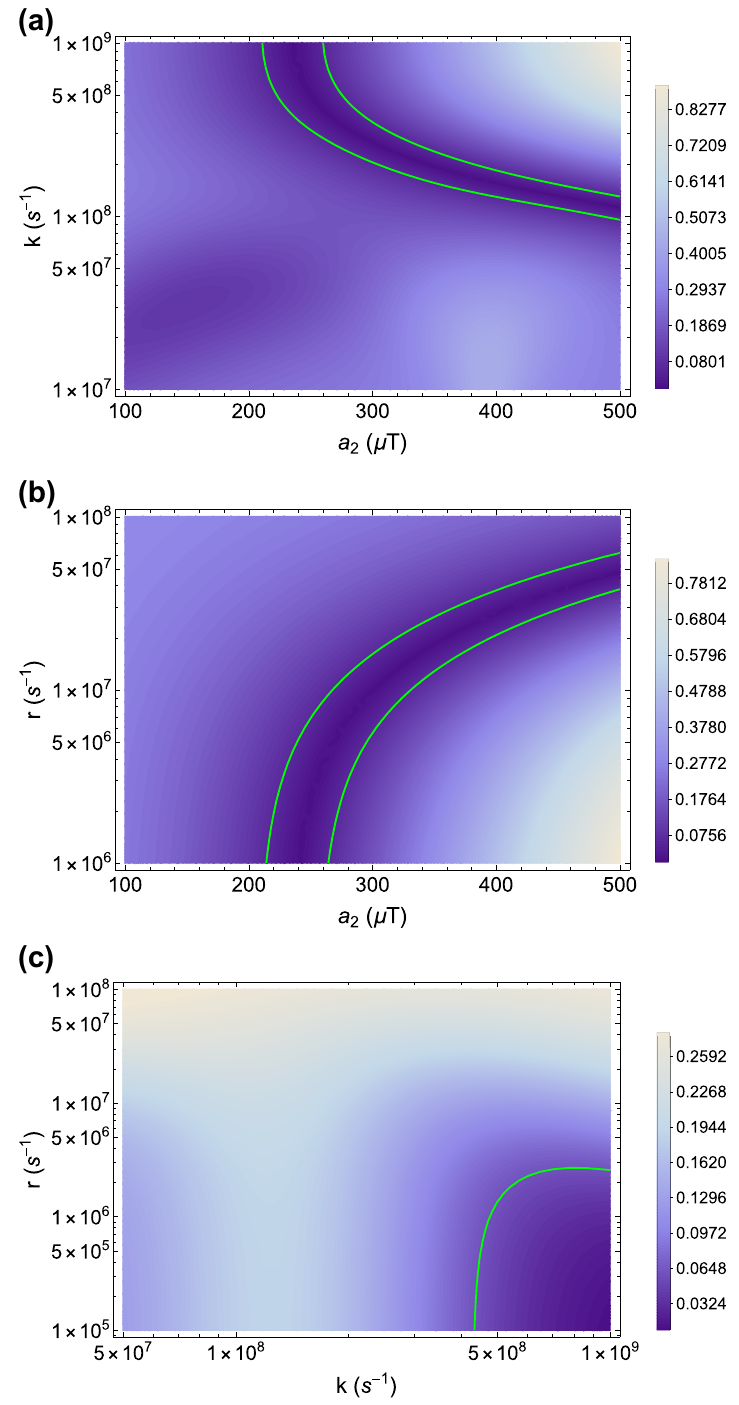
Figure 3. The dependence of the agreement between the total traveled distance ratio, TD r , and the triplet 7 6 yield ratio, TY r of Li over Li on the relationship between: ( a ) the radical pair reaction rate, k , and the lithium 6 1 hyperfine coupling constant, | a 2 | , for r = 1.0 × 10 s − ( b ) the radical pair spin-coherence relaxation rate, r , and 8 1 the lithium hyperfine coupling constant, | a 2 | , for k = 7.0 × 10 s − and ( c ) the RP reaction rate, k and the radical pair spin-coherence relaxation rate, r , for | a 2 | = 224.4 µ T. In all three cases a 1 = 523.3 µ T and B = 50 µ T. The absolute value of the difference between the prediction of radical pair mechanism, TY r , and the experimental data, TD r , is illustrated where the green line indicates the ranges smaller than the experimental uncertainty, | TD r − TY r | ≤ 0.06